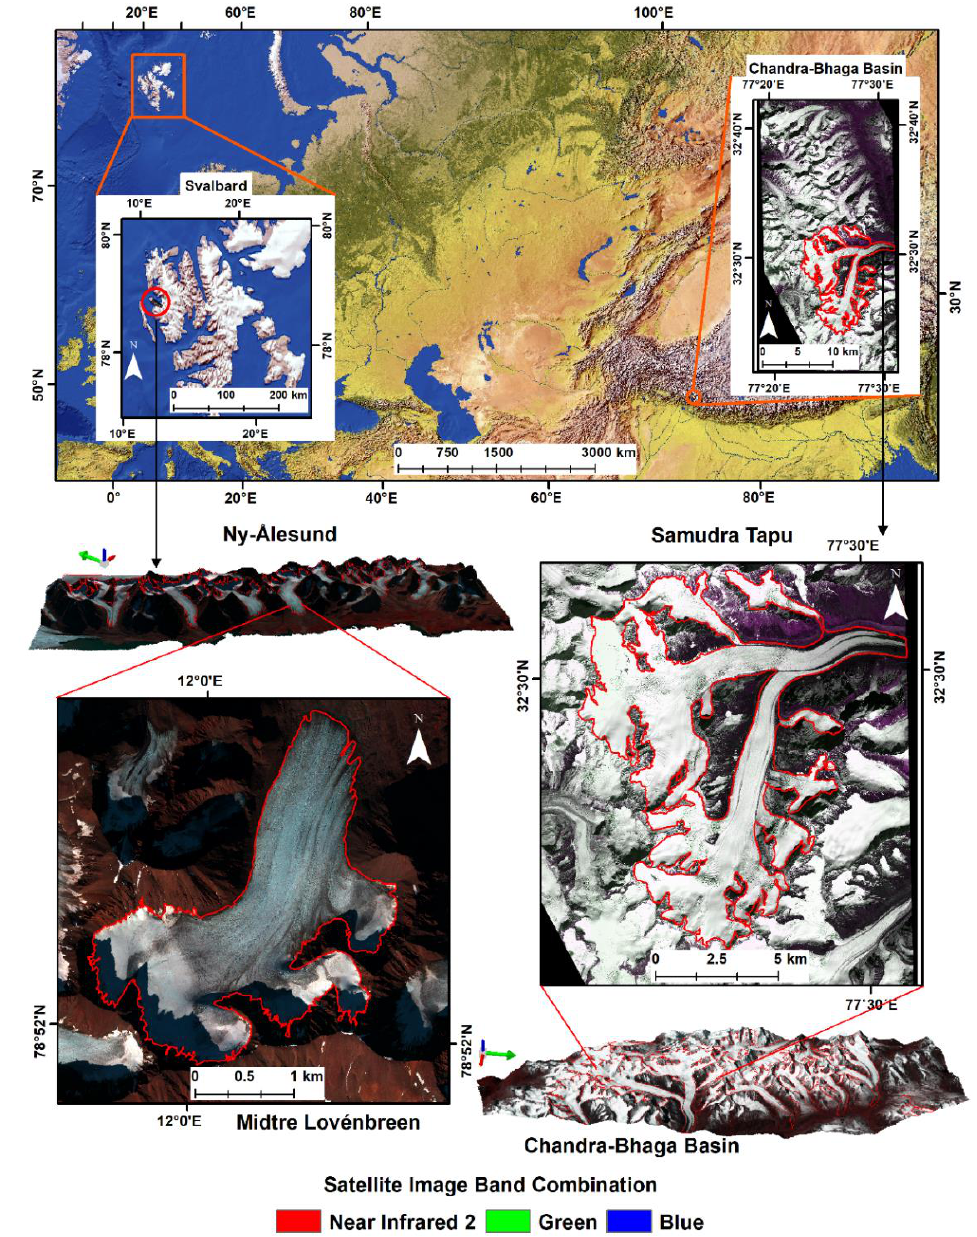
Figure 1. Geospatial location of the study areas. The 3D elevated surfaces are pansharpened images draped on digital elevation models. The insets of ML (WorldView-3 © 2016 Maxar Technologies) and ST (WorldView-2 © 2014 Maxar Technologies) are highlighted using the digitized boundary. The top image showing the global position of Svalbard and Chandra–Bhaga basin was prepared using Natural Earth (free vector and raster map data @